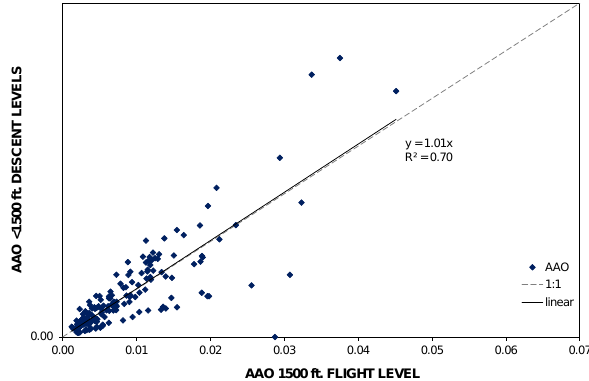
Fig. 15. Comparison of AAO aircraft calculated scattering opti- cal depth adjusted to ambient RH for the levels of the descent data below 1750feet with AAO scattering optical depth adjusted to am- bient RH for the sampling flight level at 1500feet (at